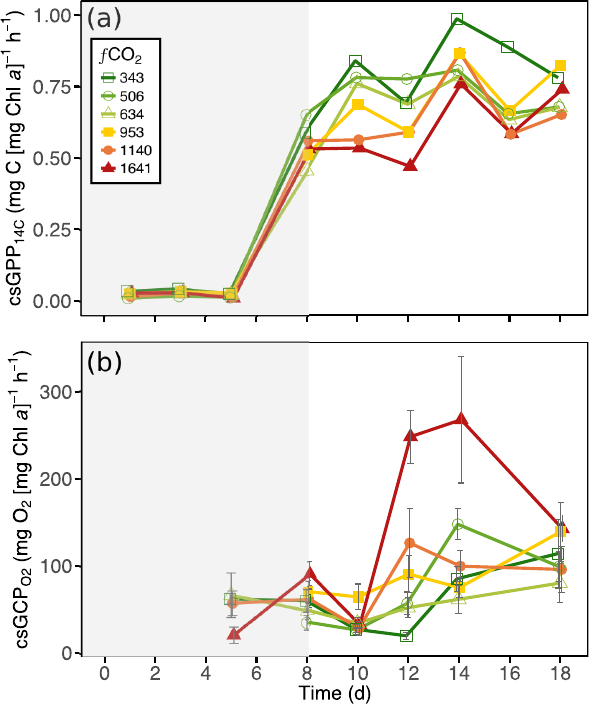
Figure 6. (a) 14 C-derived Chl a -specific primary productivity (csGPP 14 ) and (b) O 2 -derived Chl a -specific community produc- C tivity (csGCP O ) in each of the minicosm treatments over time. Er- 2 ror bars display 1 standard deviation of pseudoreplicate samples. Grey shading indicates CO 2 and light acclimation period.